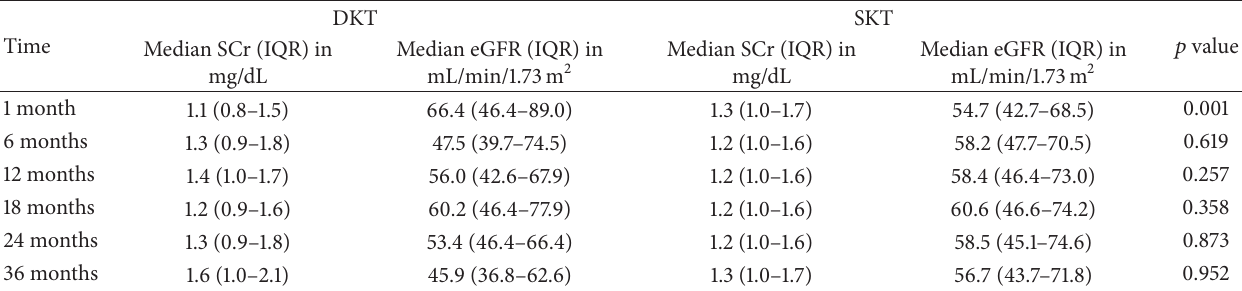
Table 2: Posttransplant renal function for dual (DKT) and single-kidney transplant (SKT)